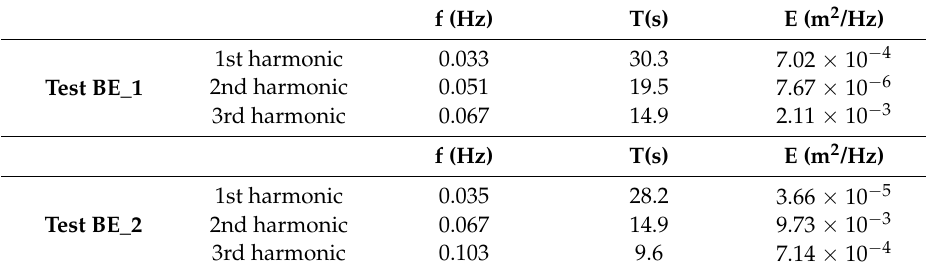
Table 3. Peak frequencies, periods and power spectral density for BE_1 and BE_2 tests.